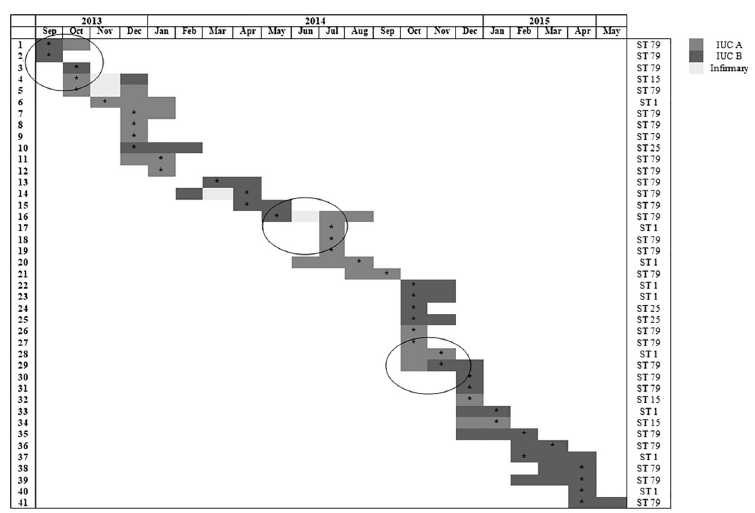
Fig 1. Time-line of events during the patient admission period. The isolation of OXA-23-producing A . baumannii strains are marked with an asterisk. The arches highlight patients who moved to a different ICU during hospitalisation.